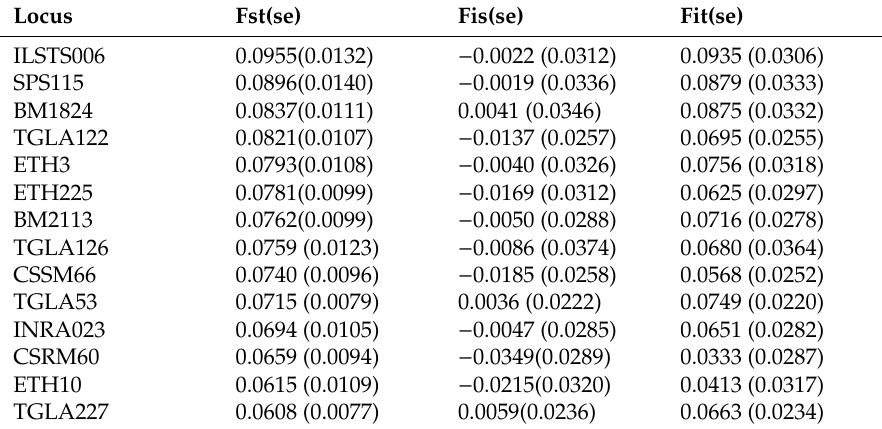
Table 4. Summary of Wright’s F-statistics for each